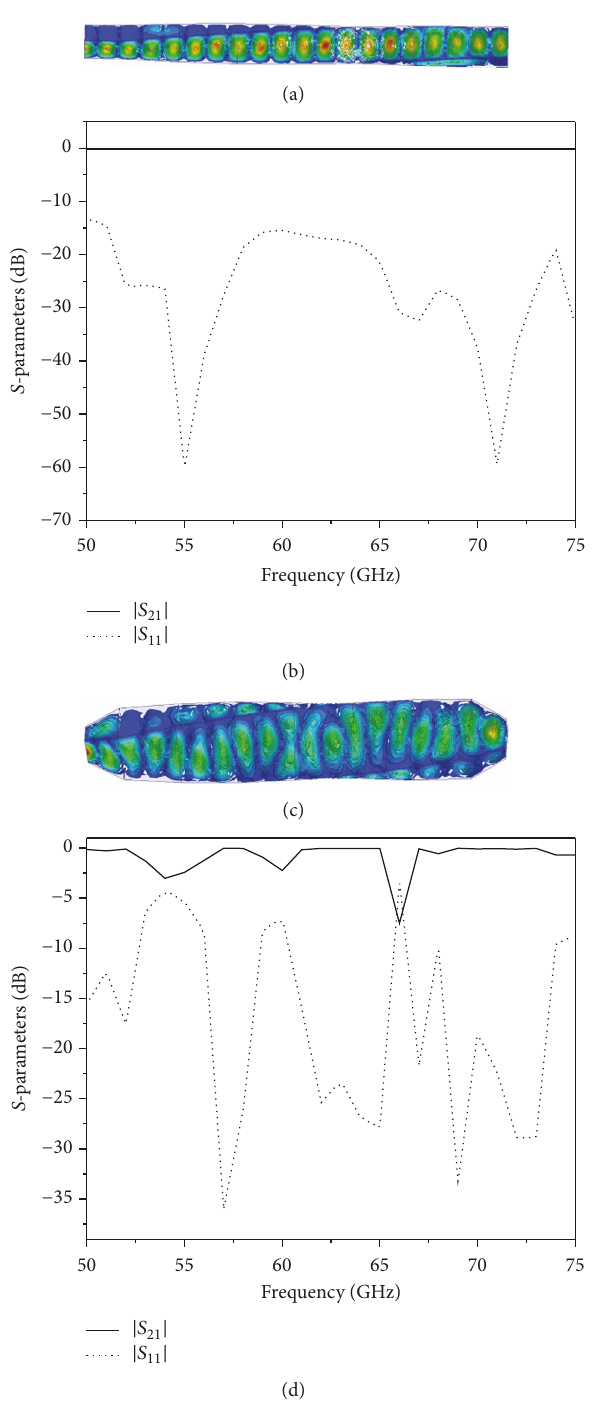
Figure 8: Fundamental mode and high order mode waveguide twists: (a) V-band fundamental mode waveguide twist, (b) fre- quency response of the V-band fundamental mode waveguide twist, (c) V-band high order mode waveguide twist, and (d) frequency response of the V-band high order mode waveguide twist.